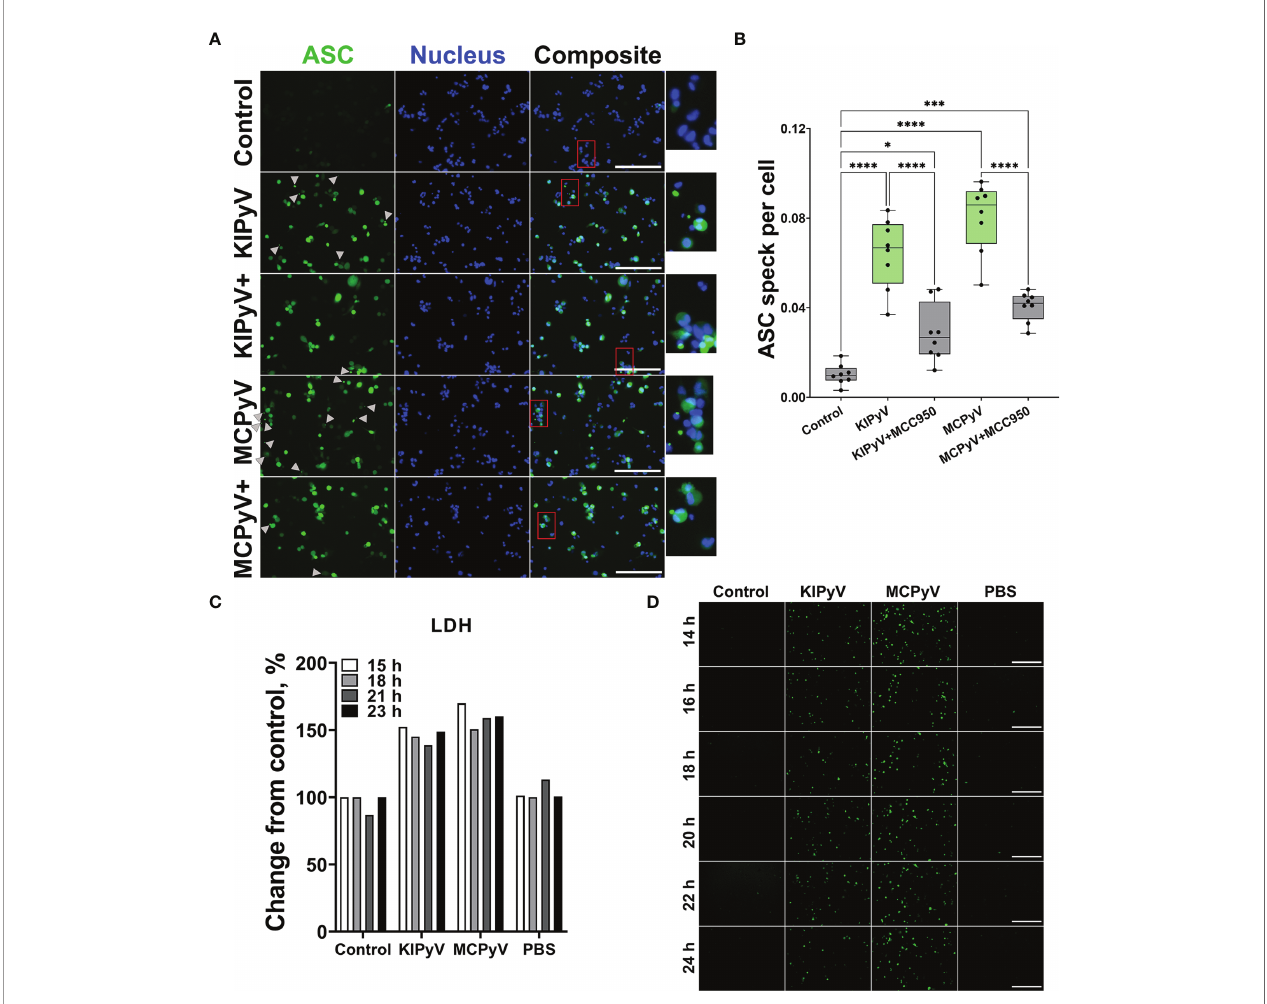
FIGURE 3 | PyV-derived VLPs induced ASC speck formation in human THP-1 macrophages. THP-1-ASC-GFP macrophages were treated for 24 h with PyV- derived VLPs (20 µg/ml); inhibitor MCC950 (1 m M) was added 30 min before treatment. (A) Formation of ASC specks was visualized by a fl uorescence microscope. Representative images of one experiment are shown. Gray arrows show ASC specks. Red rectangles show magni fi ed parts. “ + ” refers to MCC950 pre-treatment. The images were taken using 20× objective The scale bars indicate 200 m m. (B) Quanti fi cation of ASC speck count per cell. Data are represented using box plots with dots showing independent experiments, * p < 0.05, *** p < 0.001, **** p < 0.0001, one-way ANOVA followed by Tukey ’ s multiple comparison test. (C, D) Time lapse of PyV VLP-induced cell activation. (C) LDH assay performed of cell culture supernatant in wild-type THP-1 macrophages. (D) The formation of ASC specks detected in THP-1-ASC-GFP. Representative images of one experiment are shown. N =